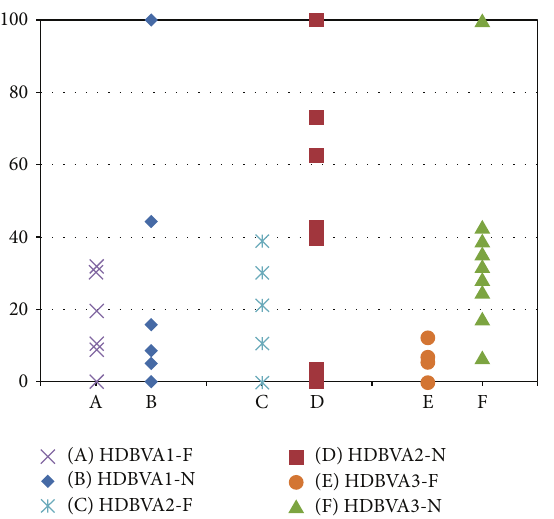
Figure 15: Out-Range slider displacement percentages of case Figure 10(b).